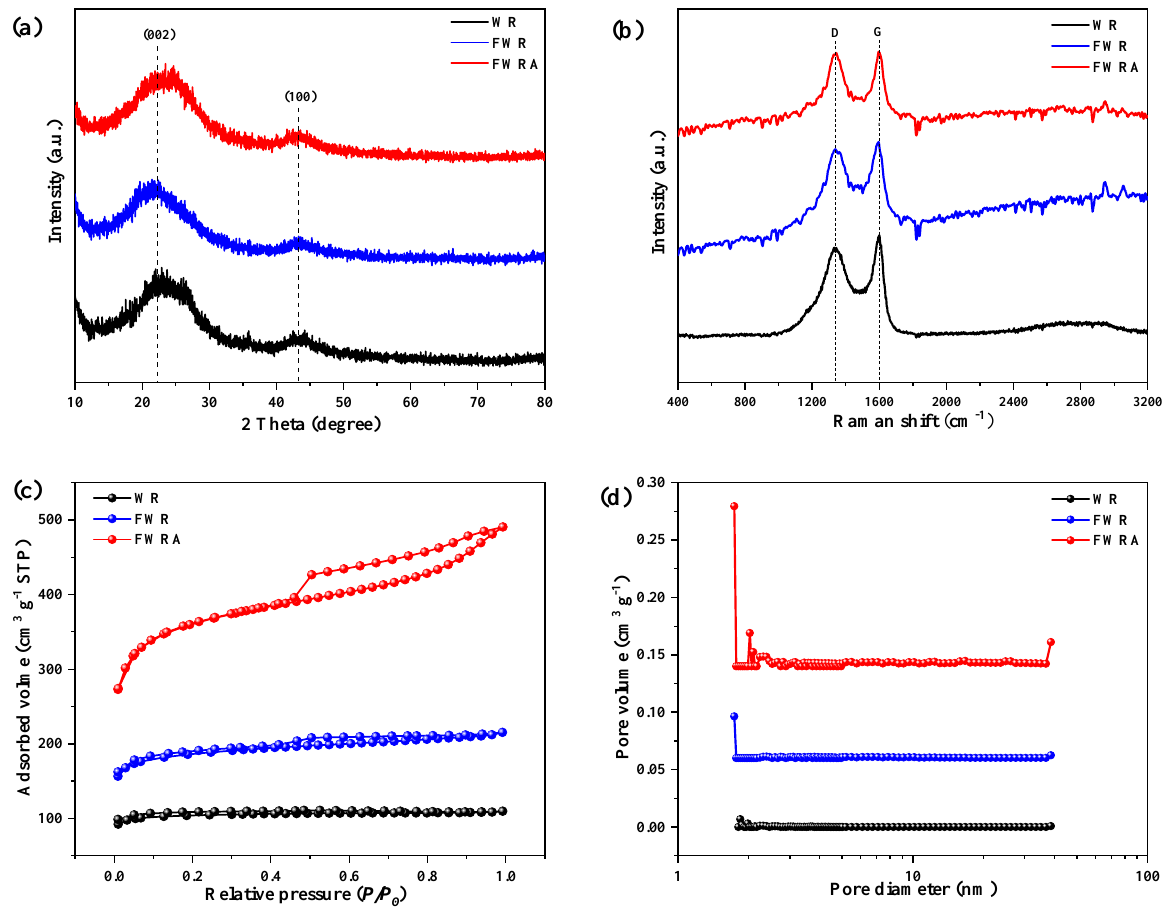
Figure 2. ( a ) XRD patterns; ( b ) Raman spectra; ( c ) N 2 adsorption-desorption isotherm; ( d ) pore size distribution. Table 1. Pore parameters of samples.